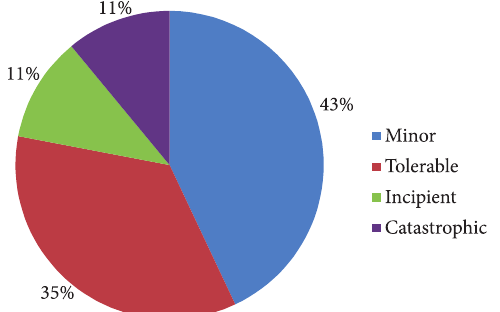
Fig. 1. Percentage distribution of reclassified failures across UK trunk road network Table 2. Fundamental Scale for Pairwise Comparisons How important is A relative to